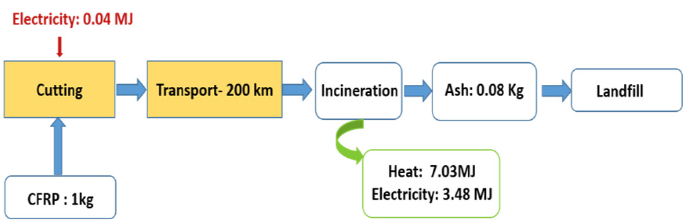
Figure 11. Flow diagram of incineration process.